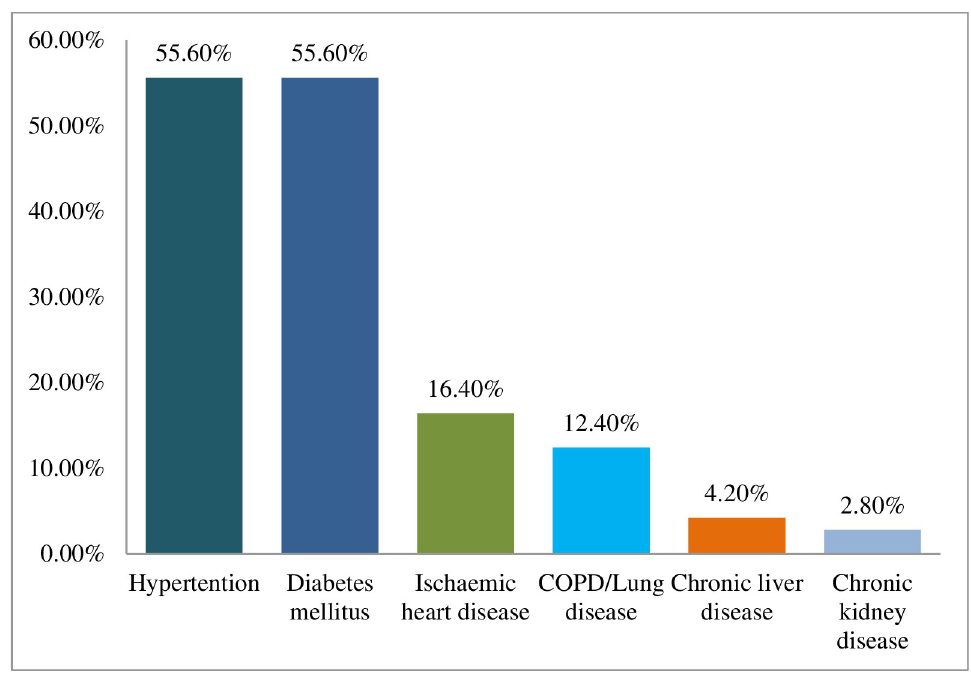
Fig 3. Distribution of the COVID-19 patients by comorbidities (n = 427).